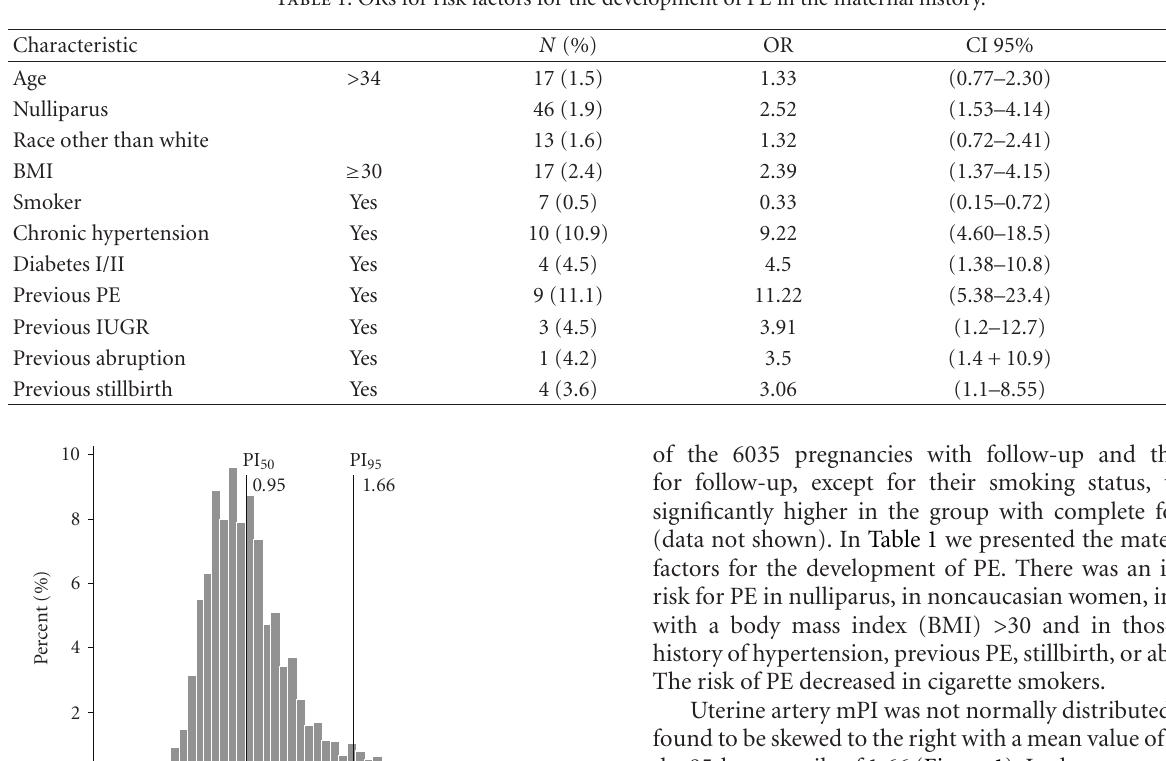
Table 1: ORs for risk factors for the development of PE in the maternal history.